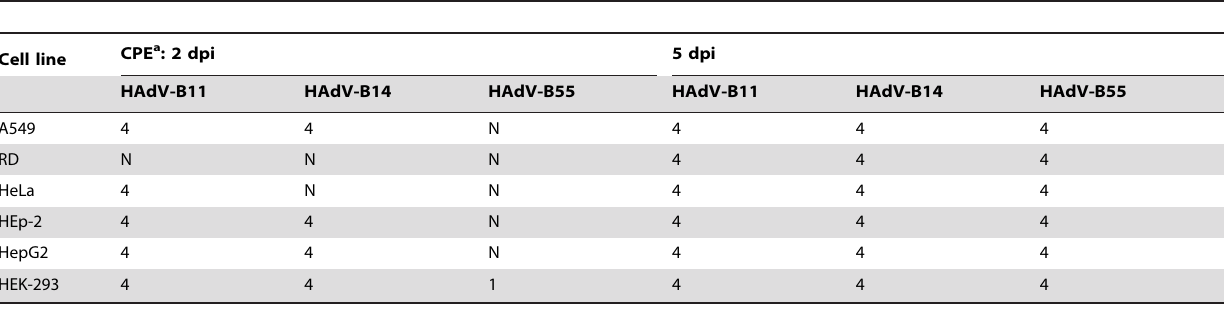
Table 2. Differential cell-line susceptibility to HAdV-B55, HAdV-B14 or HAdV-B11 in terms of the CPE.